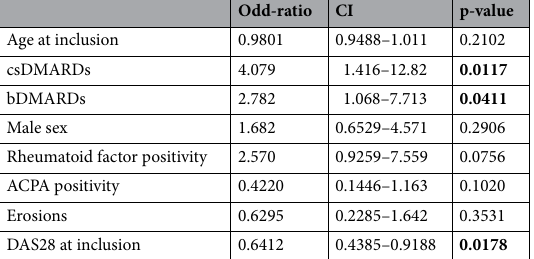
Table 4. Multivariable analysis of remission maintenance predictive factors (logistic regression) (n = 215). ACPA anti-citrullinated peptide antibodies. Significant values are in